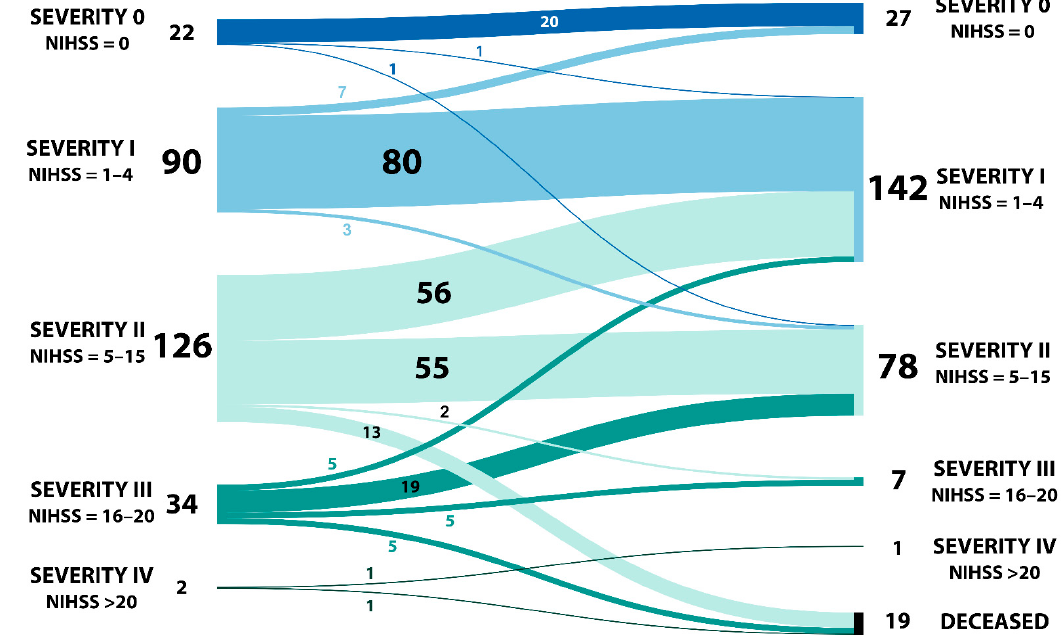
Figure 1. Patients’ distribution and pathway grouped by NIHSS at admission and discharge.